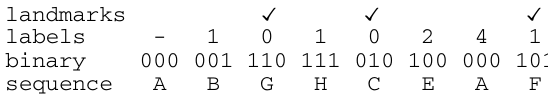
Fig. 6 Example of LPP for a sequence S � = ABABABBAB with odd length